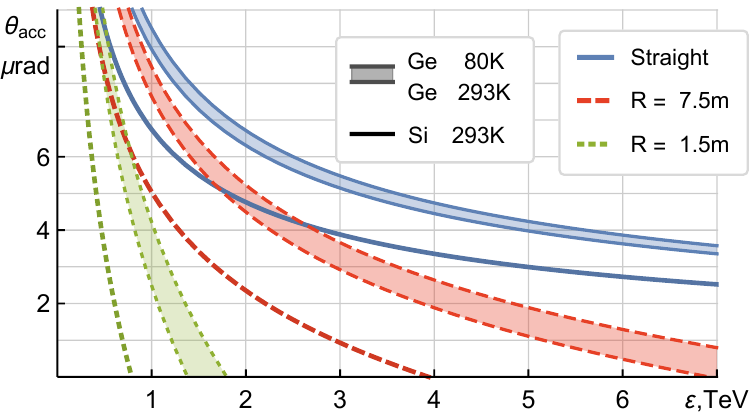
Figure 11 . Acceptance angle as a function of energy of channeled particle in germanium (thick curves) and silicon crystals. Solid blue curves are for straight crystals, dashed red and dotted green curves are for bent crystals with radii of curvature R = 7.5 m and 1.5 m, respectively. where erf( x ) is the error